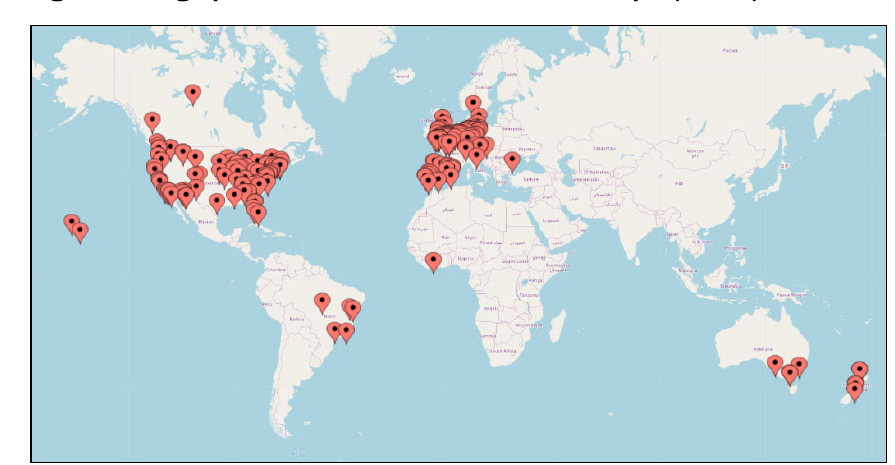
Figure 1. Geographical Distribution of Food Forest Sample ( n =209)